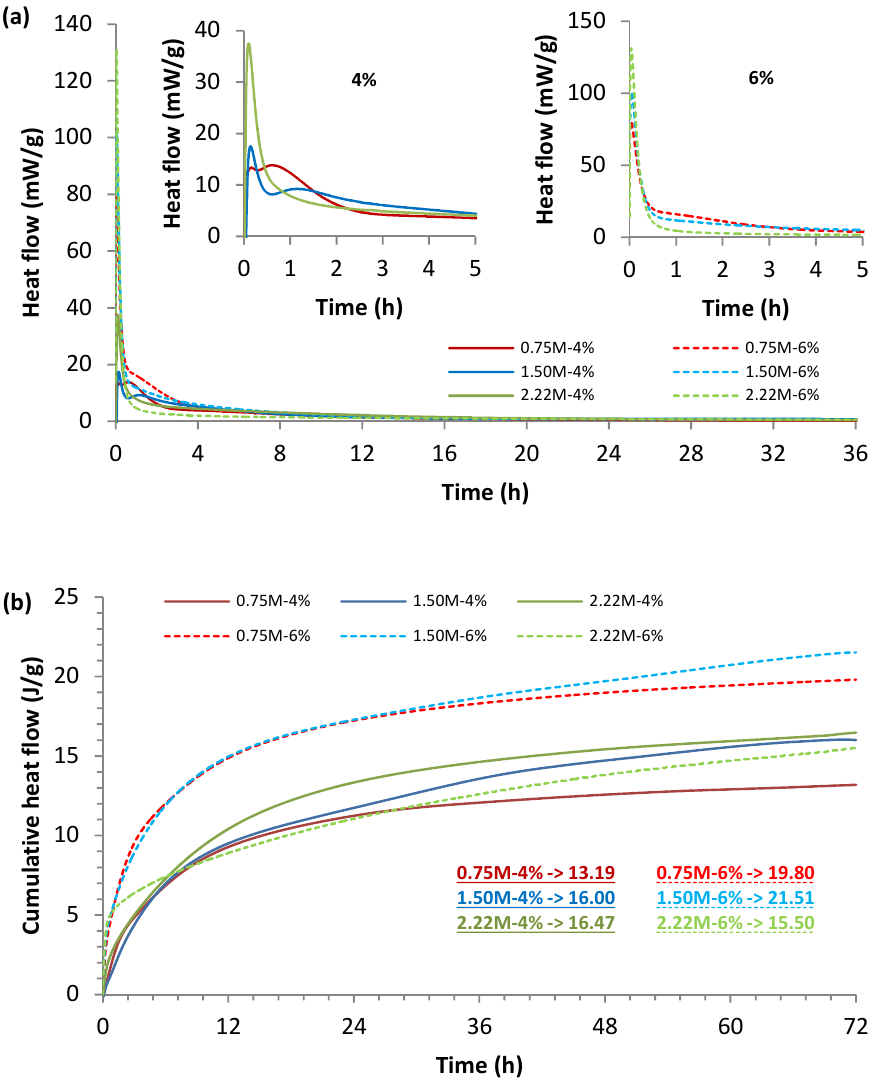
Figure 4. Hydration kinetics of the pastes: ( a ) heat flow and ( b ) cumulative hydration heat.